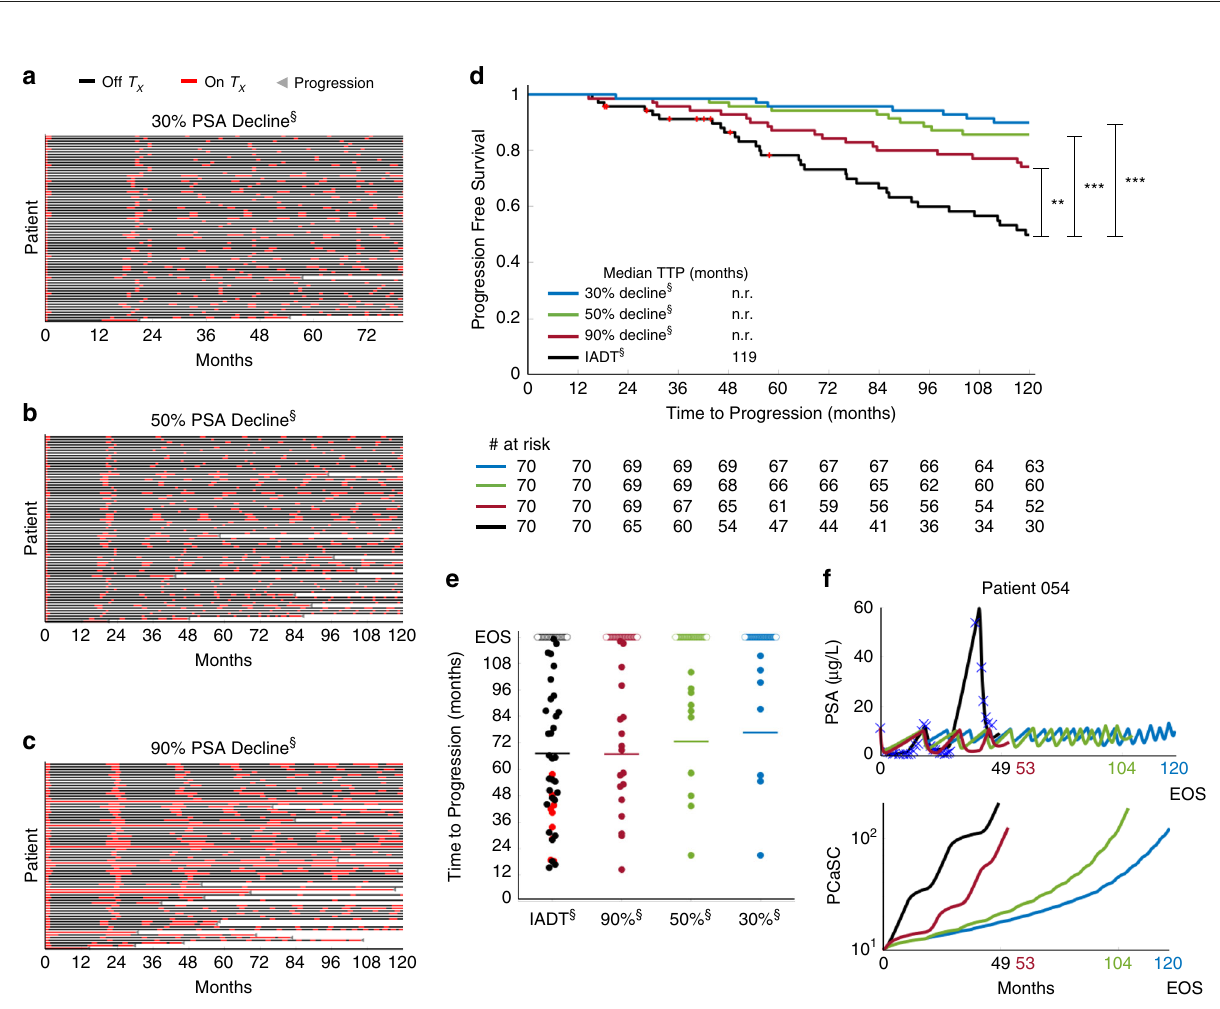
Fig. 5 Administering IADT without induction period increases TTP when compared with IADT with induction and continuous ADT. a – d Treatment times for a Bruchovsky trial data and simulations of b extrapolated IADT with induction, c IADT without induction, and d continuous ADT. Red and black denote when treatment is on and off, respectively. e Kaplan – Meier estimates of progression comparing IADT with induction (black curve) against IADT without induction (blue) and continuous ADT (gray) (double S indicates predictive model simulation). With and without induction period, IADT TTP increases when compared with continuous therapy TTP. Red symbols denote patients who experienced an adverse event/death prior to the conclusion of the trial. Statistical signi fi cance was determined using logrank test (IADT w/o induction vs. continuous: p = 0.073, IADT w/induction vs. continuous: p = 0.129, IADT w/induction vs. w/o induction: p = 0.795). f TTP comparison between IADT with induction (black), continuous therapy (gray), and IADT without induction (blue). Open circles denote end of simulation (EOS). Red dots denote patients who experienced an adverse event/death prior to the conclusion of the trial. Solid lines denote mean TTP (67.11, 57.25, and 71.87 months for IADT with induction, continuous therapy, and IADT without induction, respectively). The average TTP is longer with IADT without induction, compared with IADT with induction and continuous ADT. g Simulation results for Patient 054 (IADT with induction (black curve), without induction (blue curve), and continuous ADT (gray)). With IADT with induction, the patient became resistant after 49 months. Simulating continuous ADT would result in progression after 24 months. Simulating IADT without the induction would increase TTP by 5 months. PCaSC dynamics show that treatment selects for PCaSC population, accelerating resistance development. Dashed curve represent time when ADT is off.